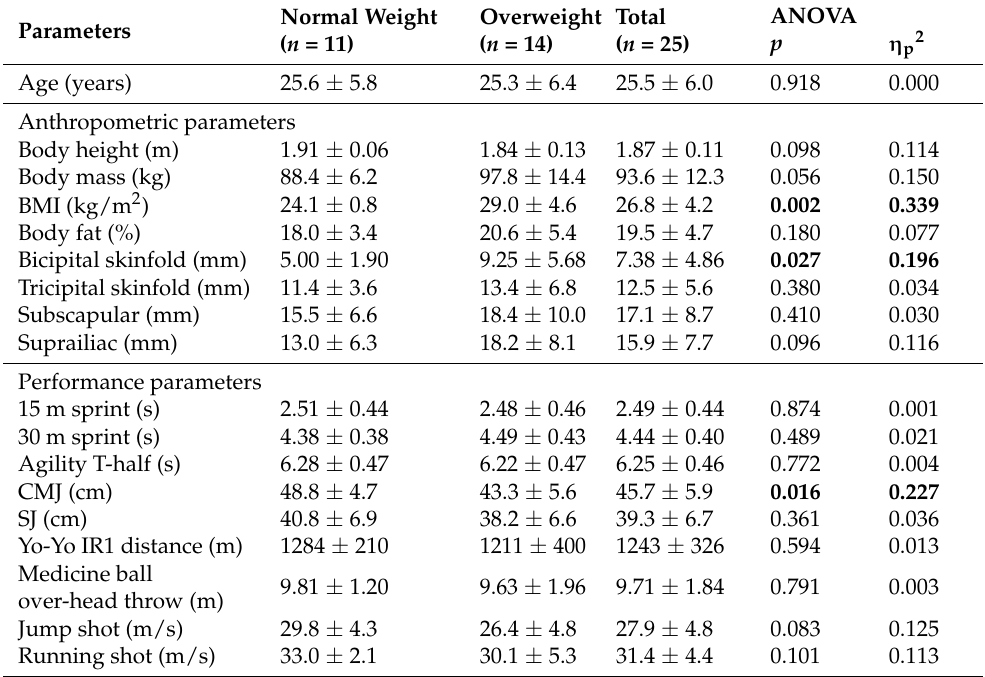
Table 2. Participants’ physical characteristics by BMI category (normal weight vs. overweight) and a comparison of the parameters between both groups based on the first testing set. Data are presented as means ± standard deviation. Significant differences ( p < 0.05 and η p2 > 0.15) are marked in